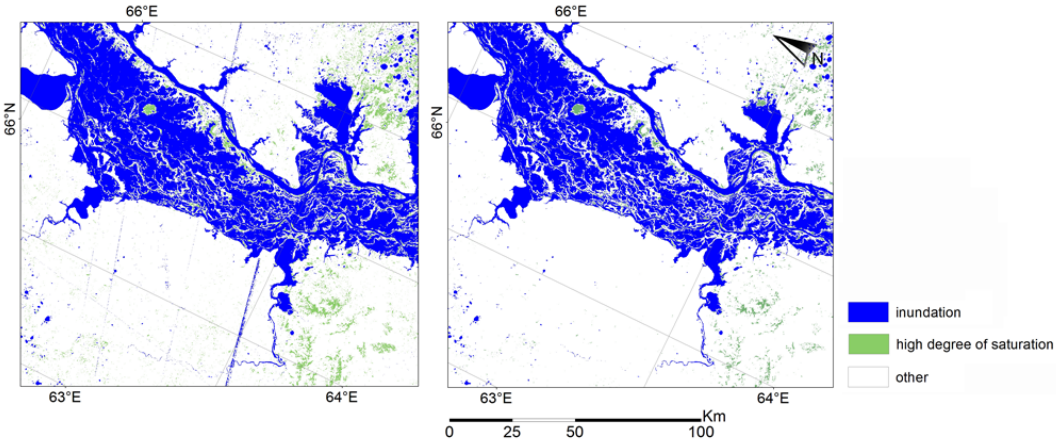
Figure 5. ( left ) h S areas and inundation classification using the minimum and maximum W of time series data, ( right ) h S areas and inundation classification using statistical measures W 5th percentile and 95th percentile of time series data. Artifacts and data errors are minimized, but the extent of h S areas is reduced as well. Universal Polar Stereographic projection, W extent: S2 in Figure